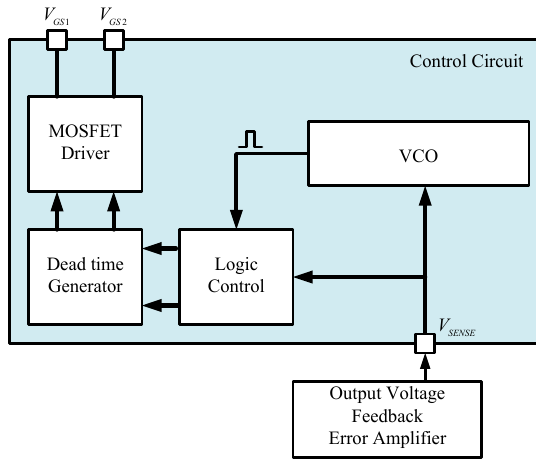
Figure 9. Block diagram of typical control circuit with burst mode. MOSFET: metal-oxide-semiconductor field-effect transistor.